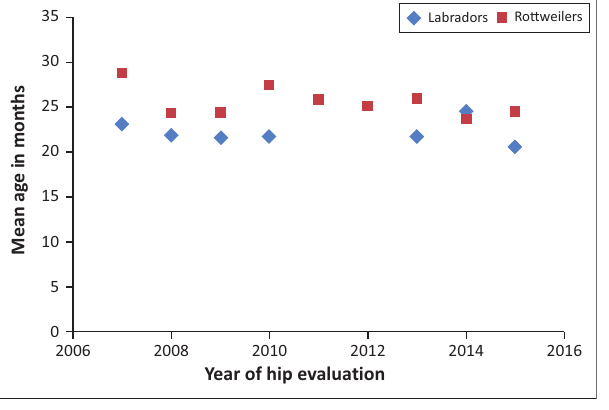
FIGURE 1: Mean age in months at hip examination in Rottweilers and Labrador retrievers per year from 2007 to 2015. TABLE 1a: Prevalence of hip dysplasia in Rottweilers and Labrador retrievers and in males versus females and primary versus secondary versus remaining scrutineers for left, right and both hips using categorical data (Grades A and B, normal; Grades C–E dysplastic). Discriminator